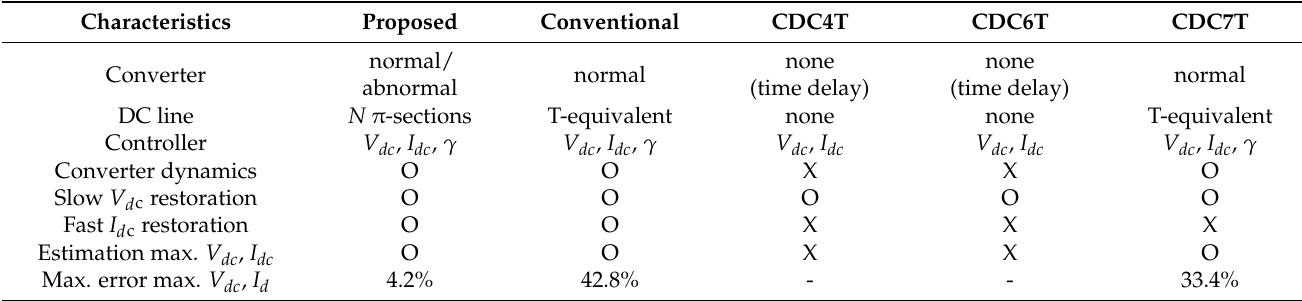
Table 9. Summary of characteristics for the proposed and generic HVDC models in PSS/E to analyze HVDC systems under abnormal operation cause by the grid